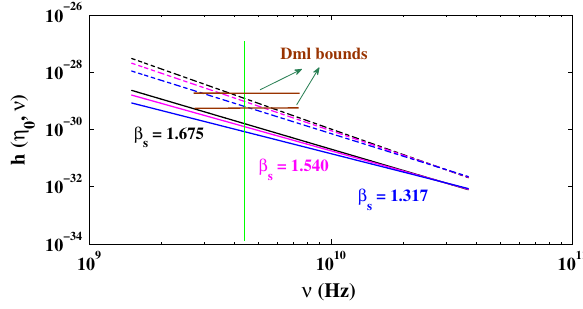
Fig. 2 The high frequency range of Fig. 1 compared to Dml sensitivity at 4.5 GHz ( green vertical line )